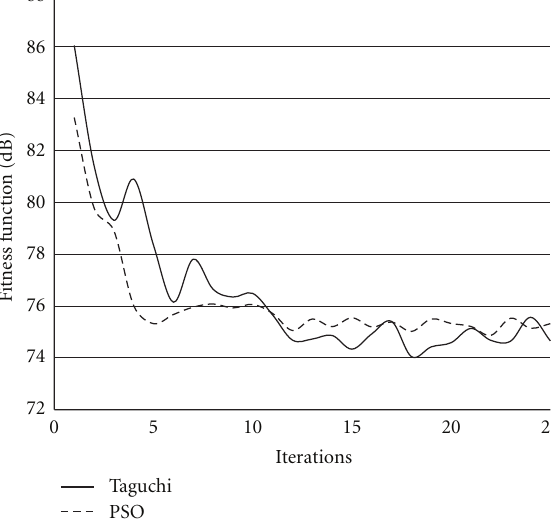
Figure 3: Taguchi and PSO optimization procedure